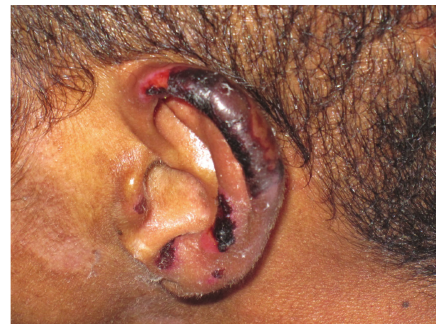
Figure 1: Magnified view of purpuric retiform lesion.